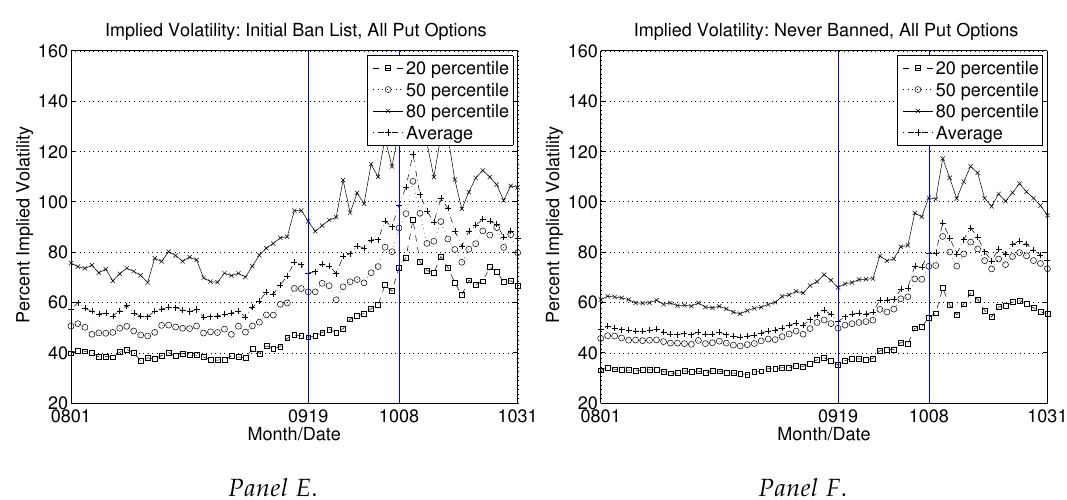
Figure 2. Time series of cross sectional options summary statistics. All put options of Initial Ban List and Never Banned Stocks during the ban and non-ban periods: ( A , C , E ) results for the three variables for Initial Ban List Stocks; and ( B , D , F ) results for the three variables for Never Banned